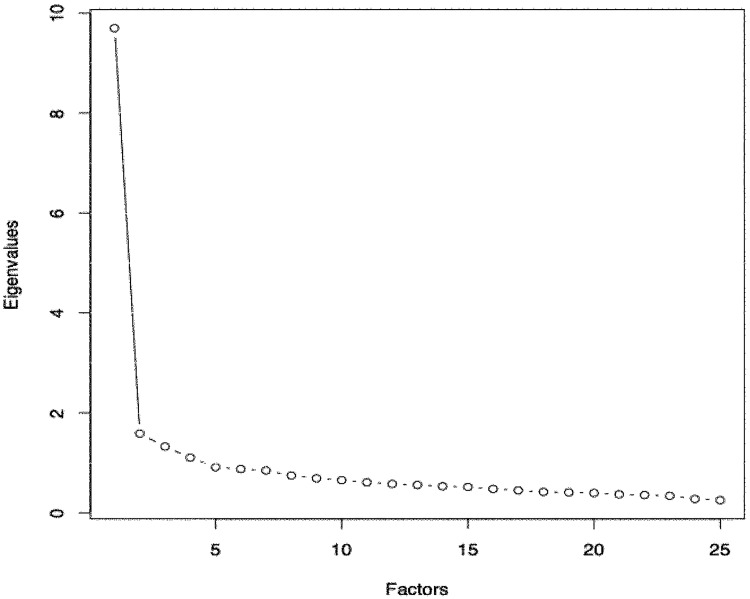
Diagram of eigenvalues.